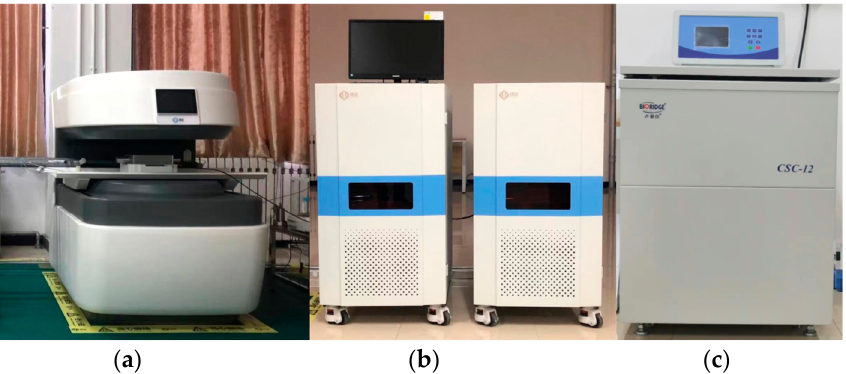
Figure 4. Experimental facilities: ( a ) magnet cabinet; ( b ) NMR device; ( c ) high-speed centrifuge.